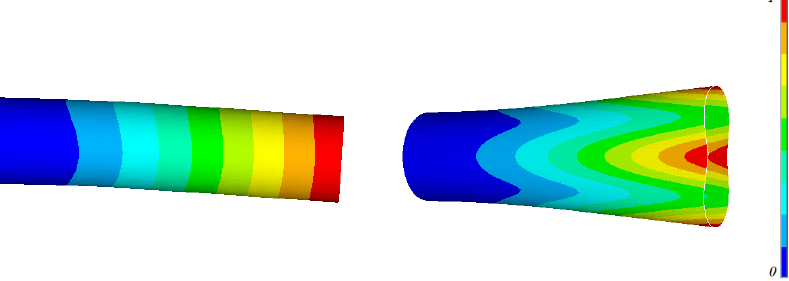
Figure 3. The first two mode shapes of thin clamped-free cylindrical shell.